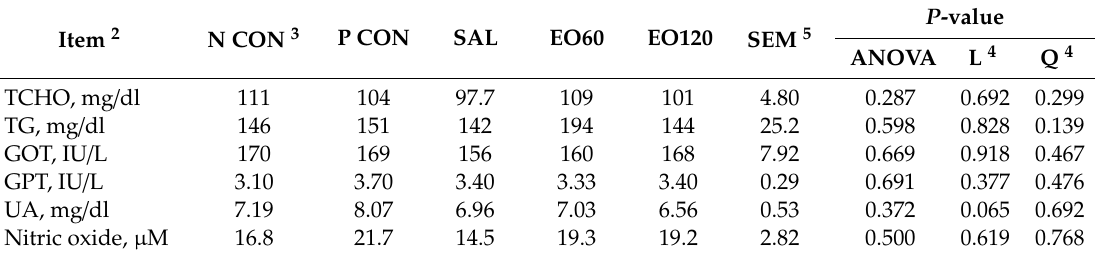
Table 7. E ff ect of supplementation of encapsulated essential oils on serum biochemical parameters in coccidiosis-vaccine-challenged broiler chickens 1.